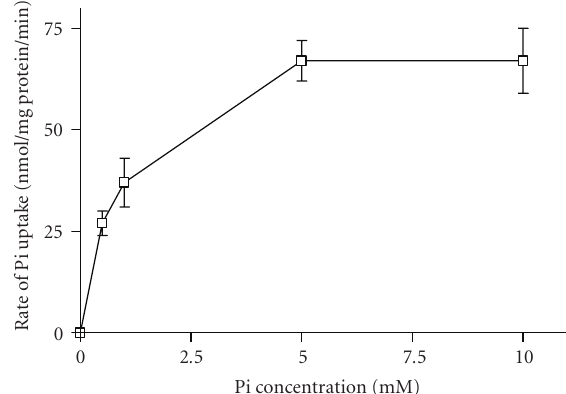
Figure 1: Uptake of phosphate in the presence of various concen- trations of phosphate (Pi). The data are the mean + SEM. The data are adapted from Sunga and Rabkin [26].